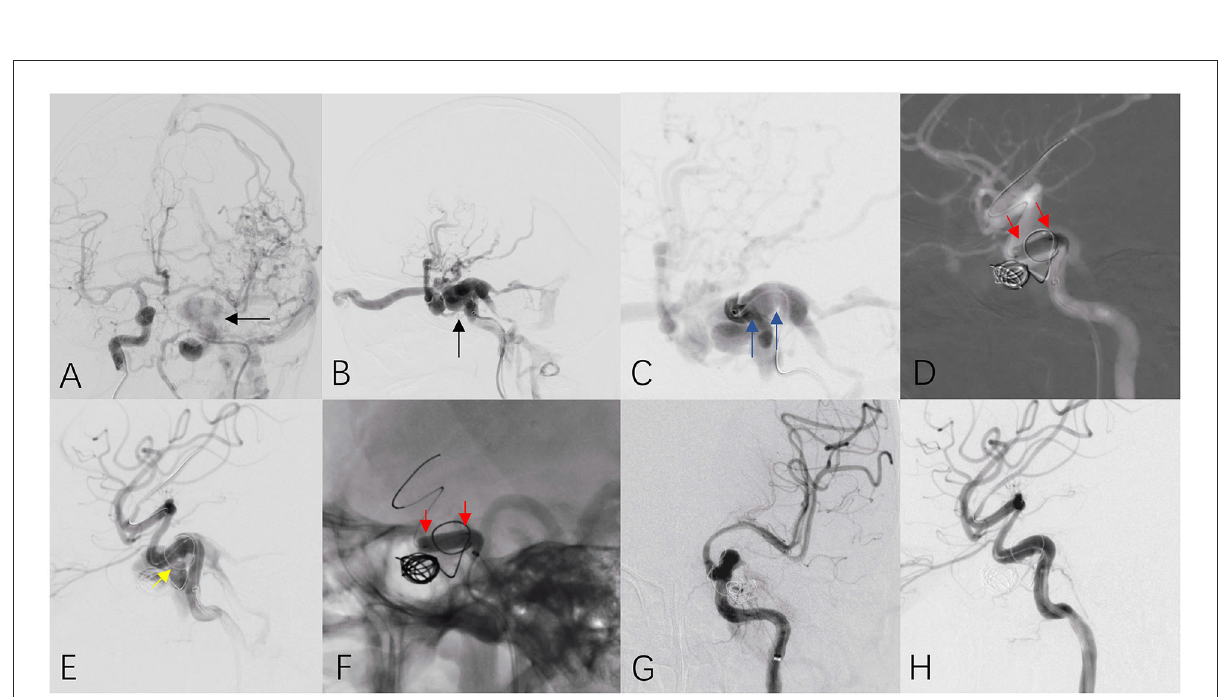
FIGURE4 A patient with traumatic carotid cavernous sinus fistula received covered stent insertion. Anteroposterior (A) and lateral (B) cerebral angiograms revealed high volume of fistula (black arrow) at the C4 segment of the left ICA. Continuous angiogram from an intermediate catheter located the fistula at the horizontal segment at C4 ( C , blue arrows). A covered stent (4.0 × 13mm) was released at the diseased parent artery ( D , red arrows) and immediate angiogram confirmed high volume of type I endoleak at the distal end of stent ( E , yellow arrow). Post dilation within the stent was performed ( F , red arrows) and final cerebral angiograms (G,H) confirmed complete disappearance of fistula and excellent patency of the parent